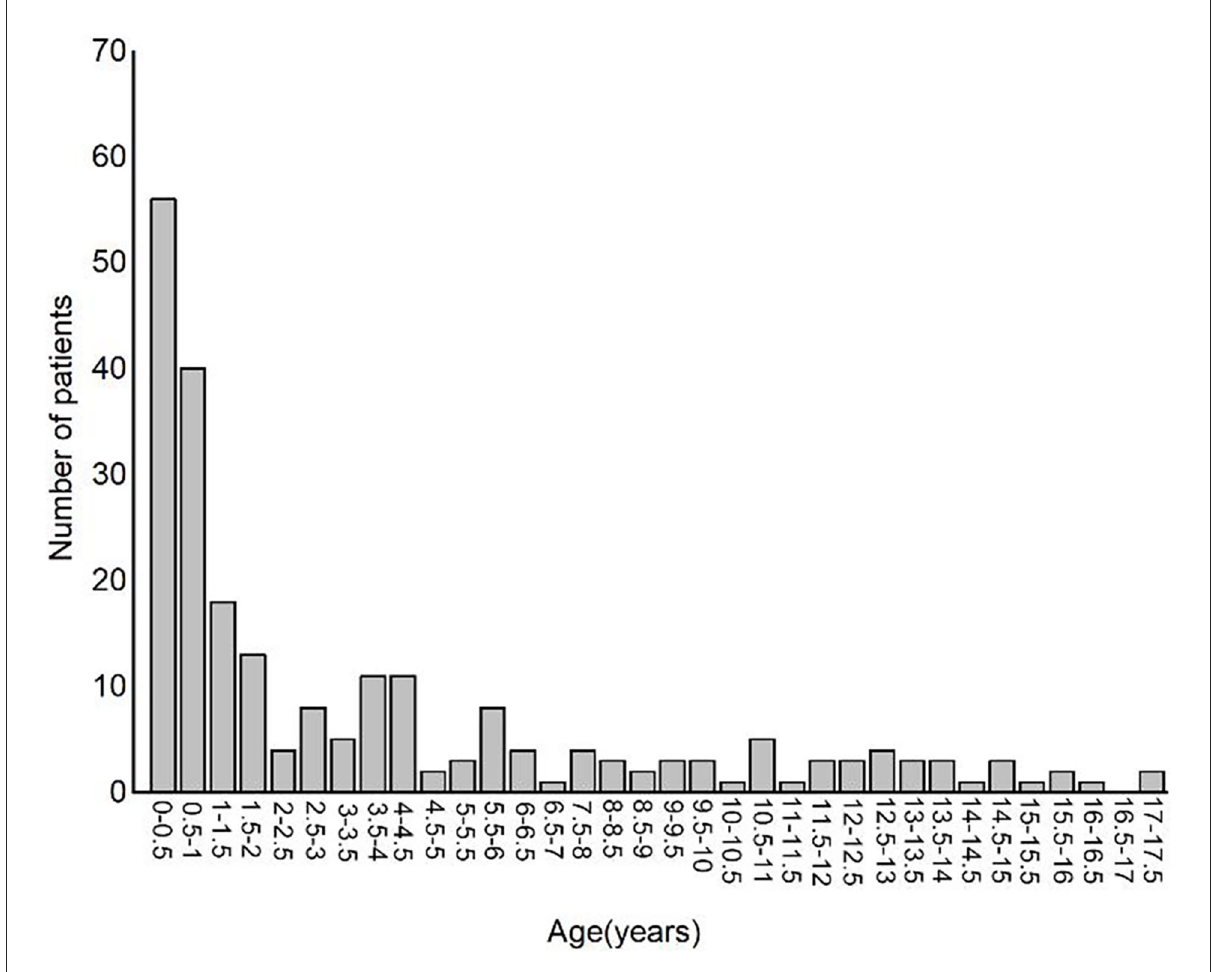
FIGURE1 Bar plot showing patient’s age